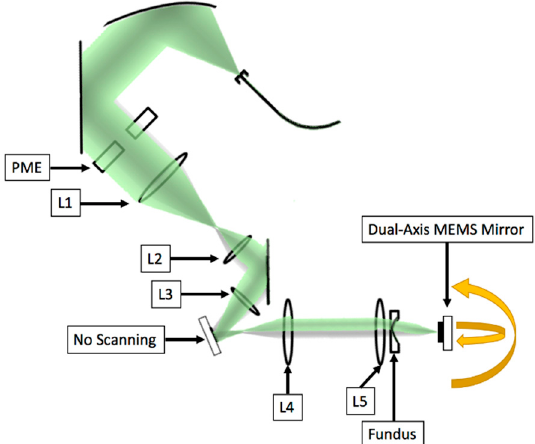
Figure 8. A dual axis MEMS mirror located at the focal plane raster scans through a range of bulk backscattering angles. The grayscale beam is the incident beam, and the green beam is an example reflected beam. The green beam, reflected with some angular deviation due to the dual-axis MEMS mirror, depicts more light travelling through the glass of the PME than the incident beam had. One would expect that the resultant images would have higher intensity in Pathlengths 2 and 3 (H 2 and H 3 ) and lower intensity in Pathlength 1 (L) compared to a beam that is reflected with no angular deviation. Depths corresponding to the MEMS mirror at Pathlengths 1–3 were isolated, and then intensity values corresponding to a given reflection angle were averaged azimuthally in reference to the neutral position (degree 0,0). Results are given in Section